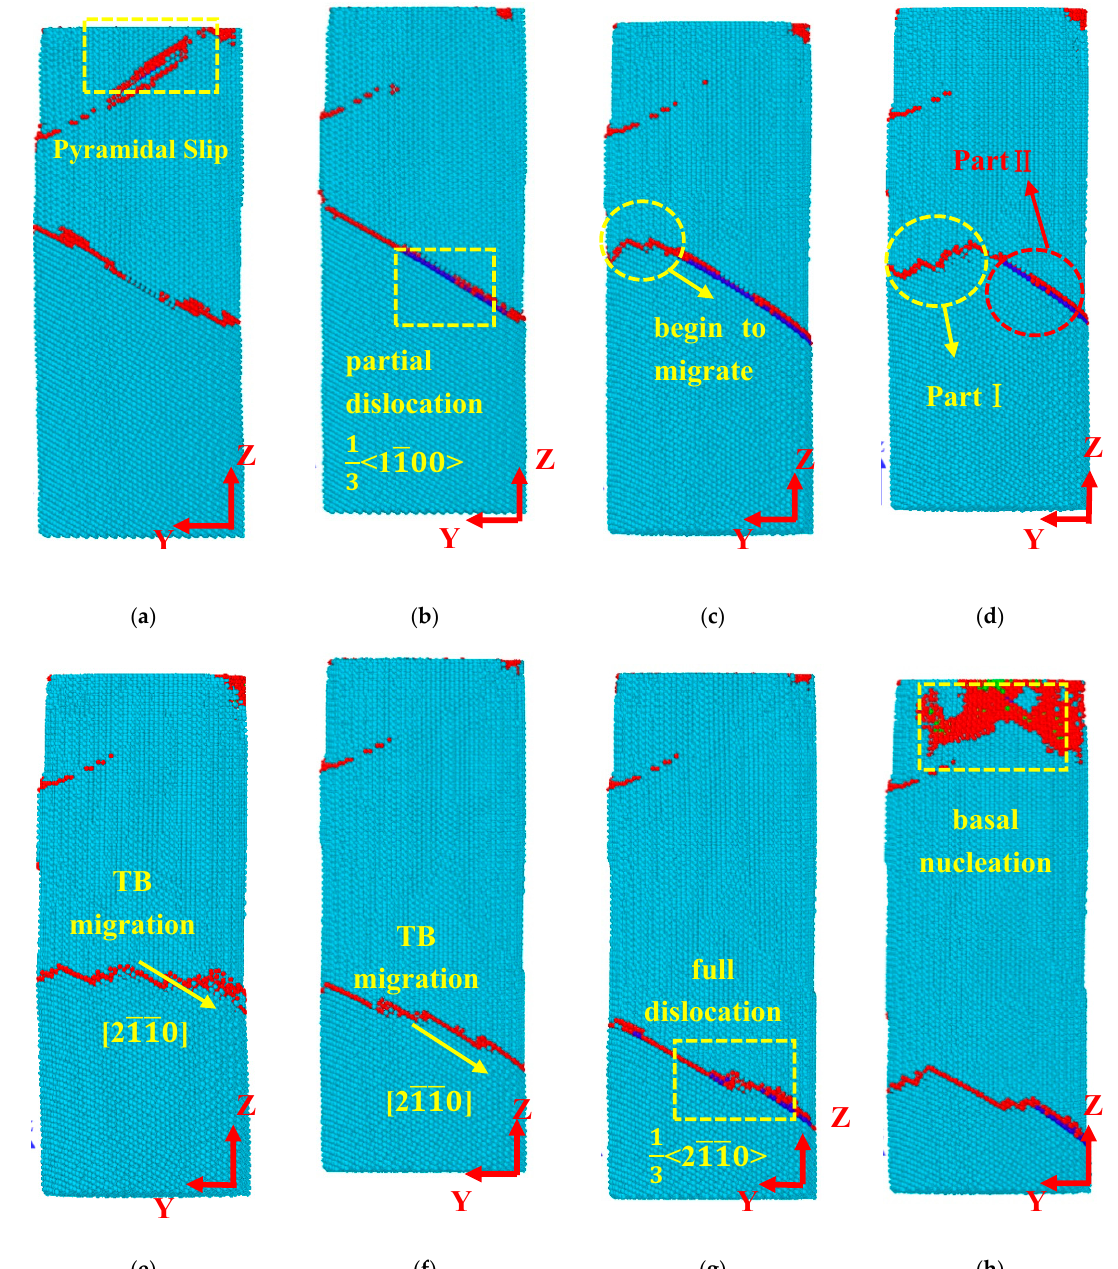
Figure 6. Deformation behaviors during the stress fluctuation stage: ( a ) ε = 0.047; ( b ) ε = 0.053; ( c ) ε = 0.056; ( d ) ε = 0.059; ( e ) ε = 0.062; ( f ) ε = 0.068; ( g ) ε = 0.074; ( h ) ε = 0.083. Images of the